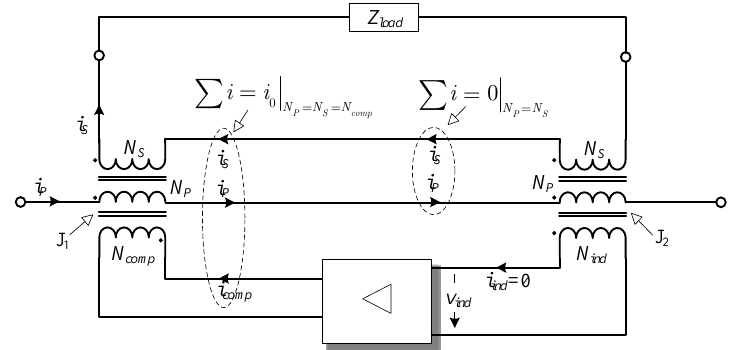
Figure 1. The EECT’s conceptual scheme .